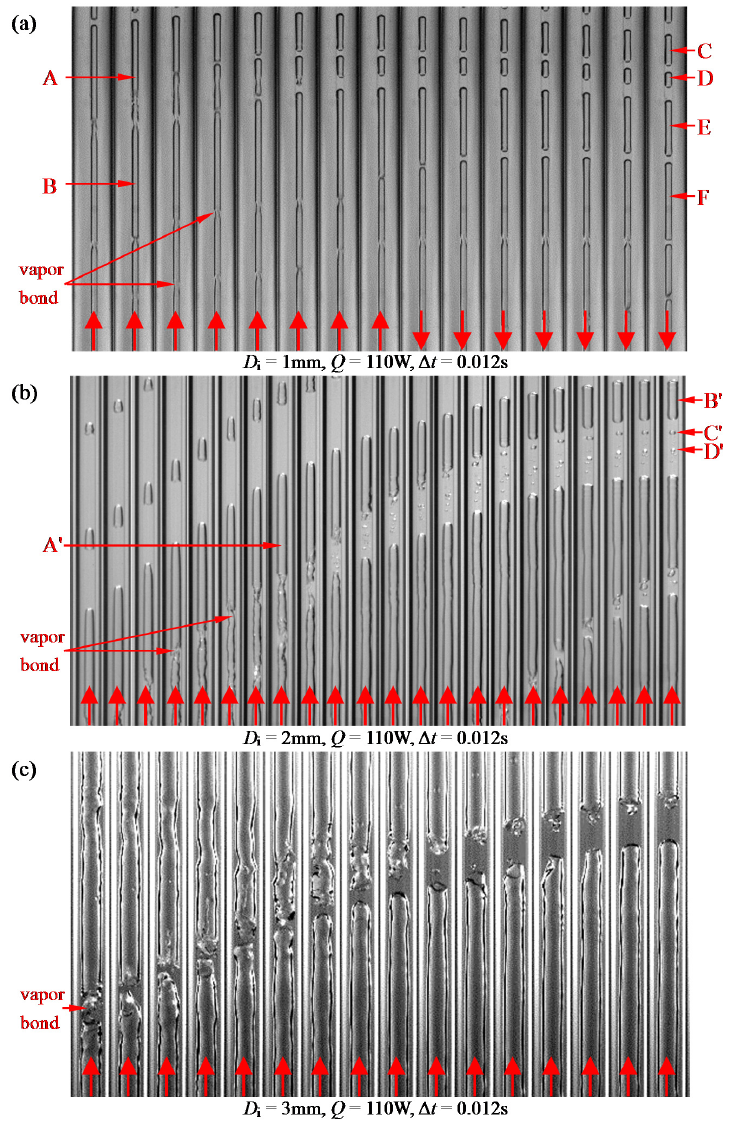
Figure 7. Evolution of flow pattern in the vertical tube at the condenser of the OHPs with different inner diameters: ( a ) snapshots of flow pattern evolution under D i = 1mm; ( b ) snapshots of flow pattern evolution under D i = 2mm; and ( c ) snapshots of flow pattern evolution under D i = 3mm.